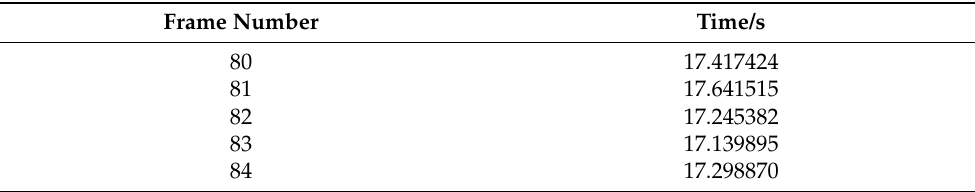
Table 4. Processing